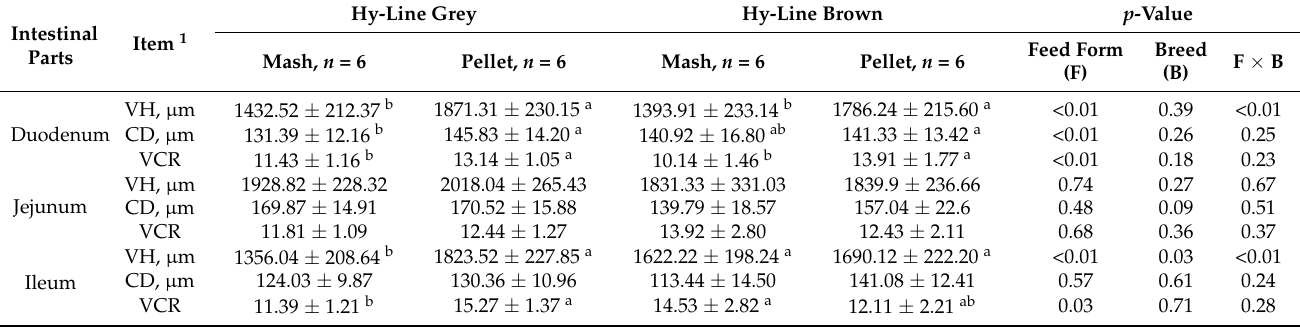
Table 7. Effects of feed form on the intestinal morphology structure of